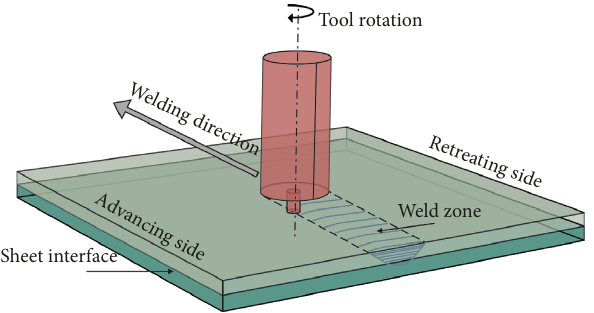
Figure 1: Schematic of friction stir welding.